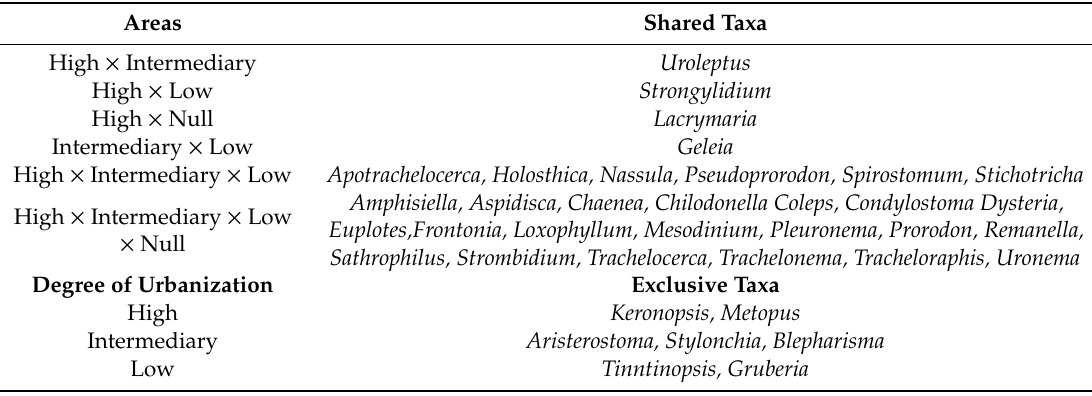
Figure 5. Venn Diagram for the occurrence of marine interstitial ciliates genera in the four degrees of urban development of sandy beaches in northern Rio Grande do Sul state (RS), Brazil, based on data collected during the study period (June 2016 to July 2017). Table 2. Genera shared or exclusive from the areas with different degrees of urban development observed between June 2016 and July 2017 in sandy beaches from northern Rio Grande do Sul state.